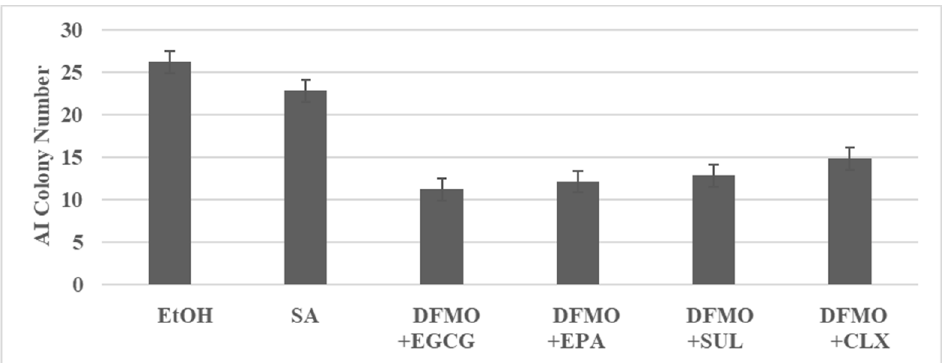
Figure 1. Combinatorial effects of test agents in 850 MIN COL model. AI colony number is determined at day 14 after seeding 100 cells. Data presented as mean ± SD, n = 12 per treatment group, and analyzed by ANOVA with Dunnett’s multiple comparison test ( α = 0.05). EtOH, ethanol; SA, single agent; DFMO, difluoromethyl ornithine; EGCG, epigallocatechin gallate; EPA, eicosapentaenoic acid; SUL, sulindac; CLX, celecoxib; ANOVA, analysis of variance. Data summarized from [24].